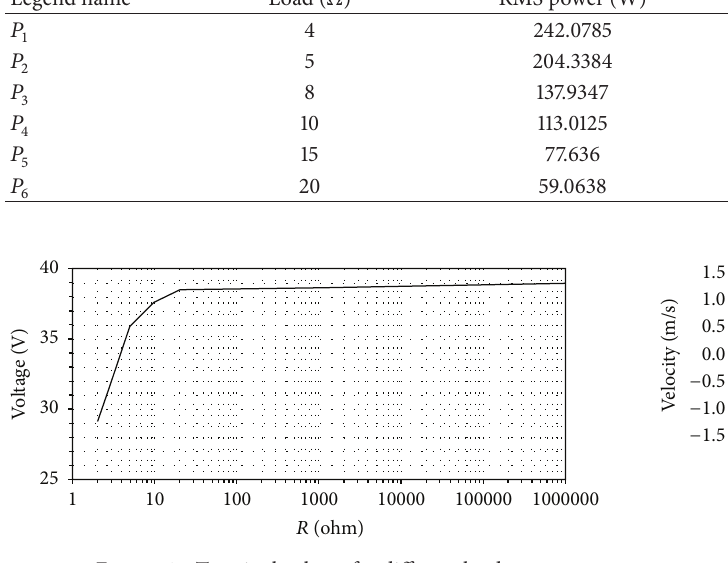
Figure 15: Terminal voltage for different loads.